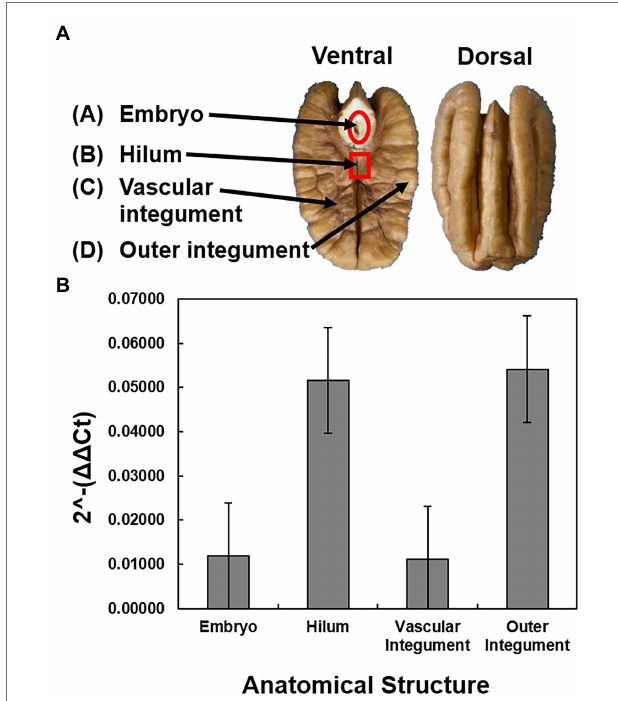
FIGURE 2 | Sampling and quantification of X. fastidiosa in different anatomical structures of cultivar Cape Fear seeds. Four anatomical structures were dissected from four pecan seeds from a pecan bacterial leaf scorch diseased mother tree. (A) Anatomical diagram of a pecan seed. The pecan seed is cut across the longitudinal plane of the middle septum, with both the ventral and dorsal sections represented. Arrows indicate the embryo, hilum, vascular integument, and outer integument, respectively. (B) The 2 - ΔΔ Ct of X. fastidiosa DNA amplification normalized to pecan DNA amplification within each anatomical structure was estimated using qPCR. Error bars indicate standard errors of the mean